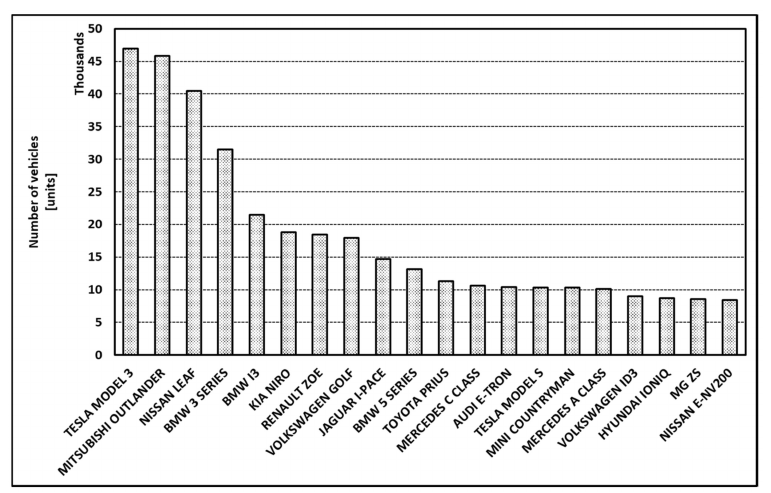
Figure 8. The most popular EVs in the UK in the second quarter of